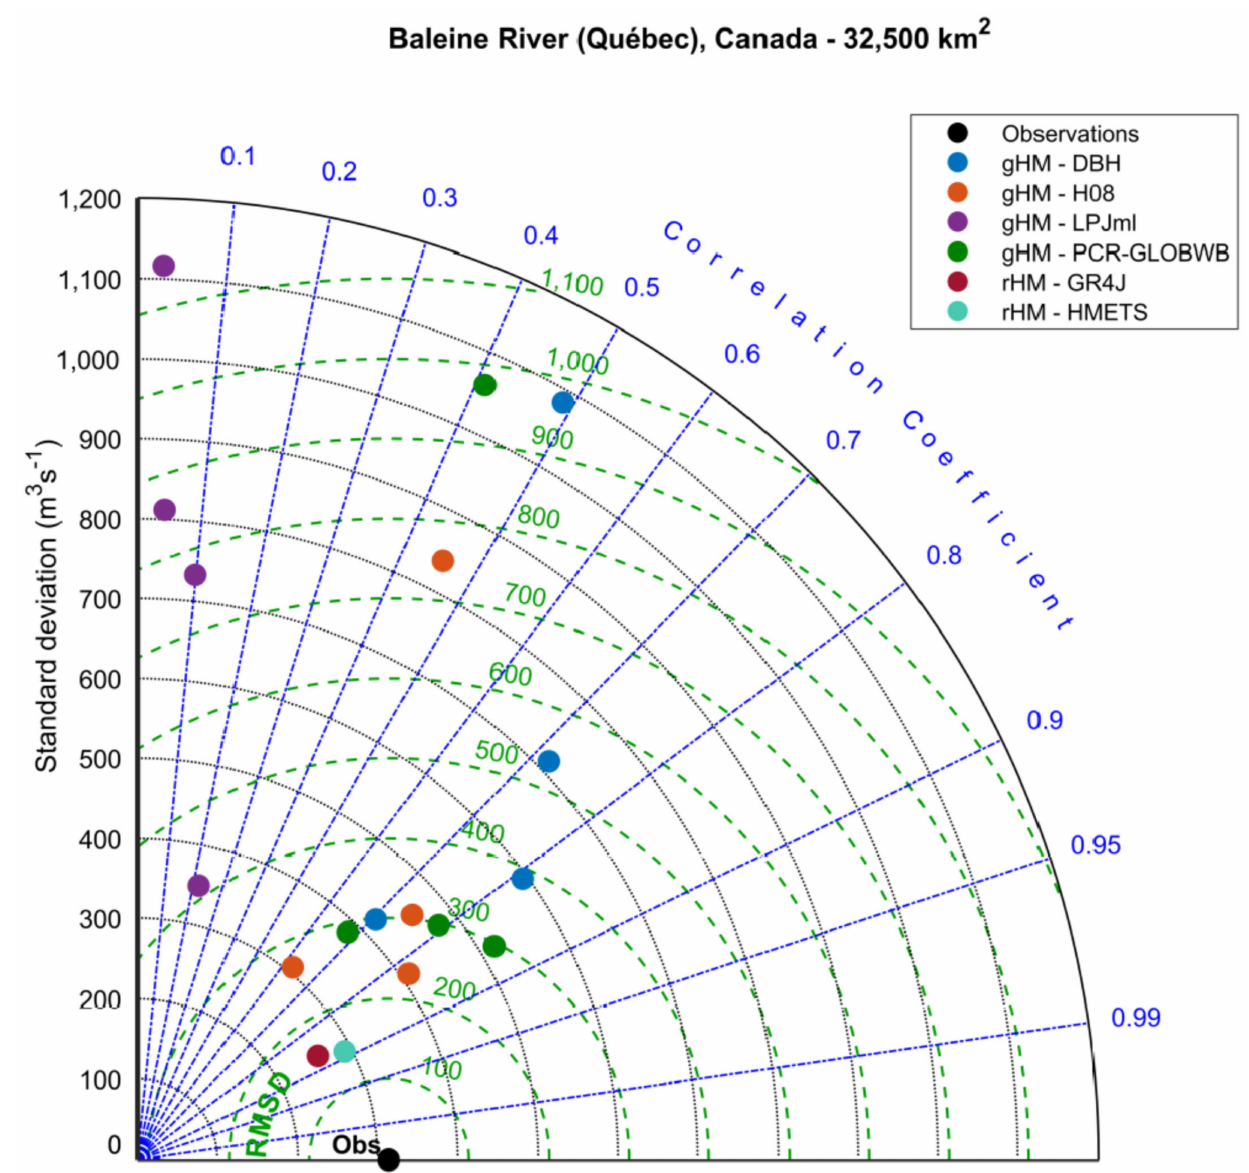
Figure 10. Taylor diagram exploring the performance of the 16 gHM–climate–dataset combinations and the two rHMs with respect to the discharge observations for the Baleine River Basin in Quebec (Canada; S = 32,500 km 2 ) over the 1971–2010